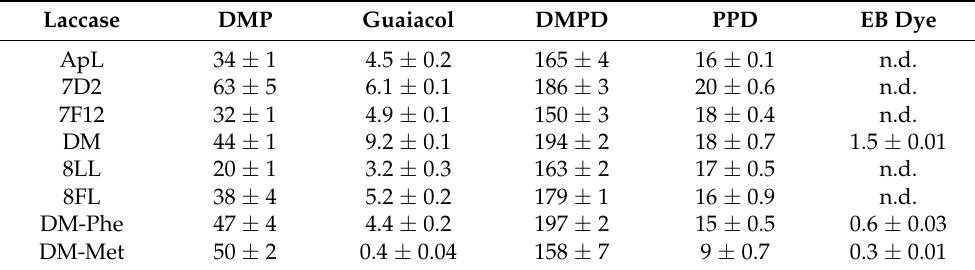
Table 3. Activities of native ApL and its developed variants for the oxidation of phenols, aromatic amines and EB dye relative to the activity with ABTS (same activity units—100 mU/mL—of each enzyme with ABTS added in all assays); n.d.: non